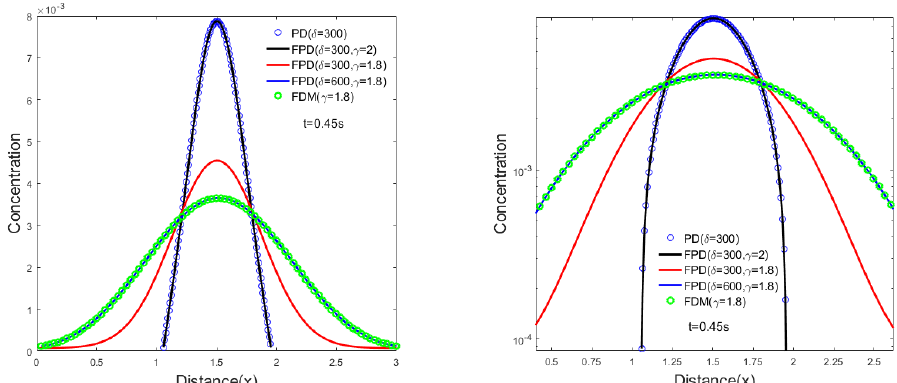
Figure 3. The concentration profiles of the PD model with near-field range δ = m ( ∆ x ) = 300, the FDM with space fractional index γ = 1.8, and the FPD model at different space indexes and near-field ranges: γ = 1.8, δ = 300; γ = 1.8, δ = 600; γ = 2, δ = 300. Other model parameters were D α = 1.0, L = 3, and t = 0.45 s. The right plot is the semi − log form.